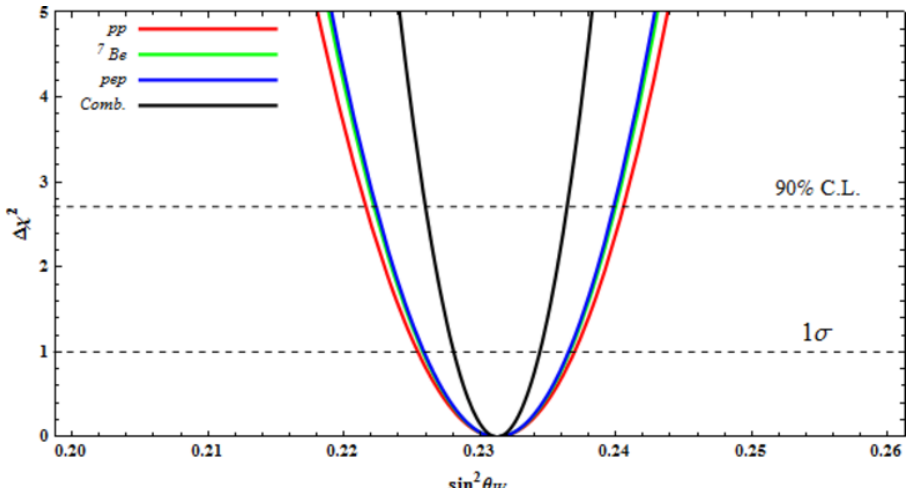
Figure 4 . Future prospects: low-energy solar neutrinos (cid:12)t to SM sin 2 ( (cid:18) W ). From bottom to top, the 1 (cid:27) and 90%C.L. bands are shown. The experimental rates are assumed to be those of the standard model with sin 2 ( (cid:18) W ) set to the MS value at the Z-boson mass. At 5 (cid:27) the allowed value of sin 2 ( (cid:18) W ) ranges up to 0. 2382.